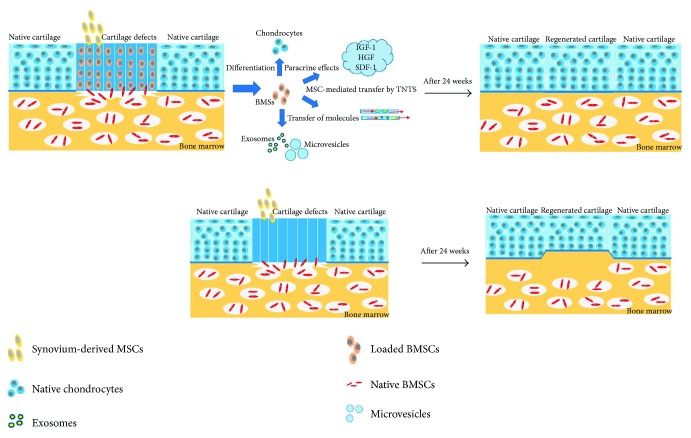
A potential cartilage regeneration mechanism in the MSC-loaded scaffold group. MSCs can differentiate directly into chondrocytes or may secrete growth factors (e.g., insulin-like growth factor (IGF-1) or hepatocyte growth factor (HGF)), rescuing injured tissue. MSCs may also transfer mitochondria via tunneling nanotubes or microvesicles or secrete specific exosomes or microvesicles, influencing surrounding cells.